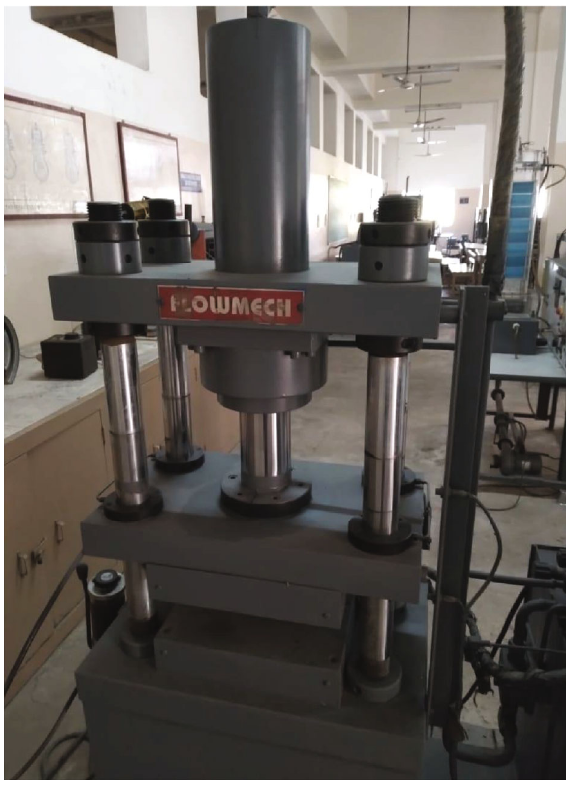
Figure 1: Hot press machine setup.